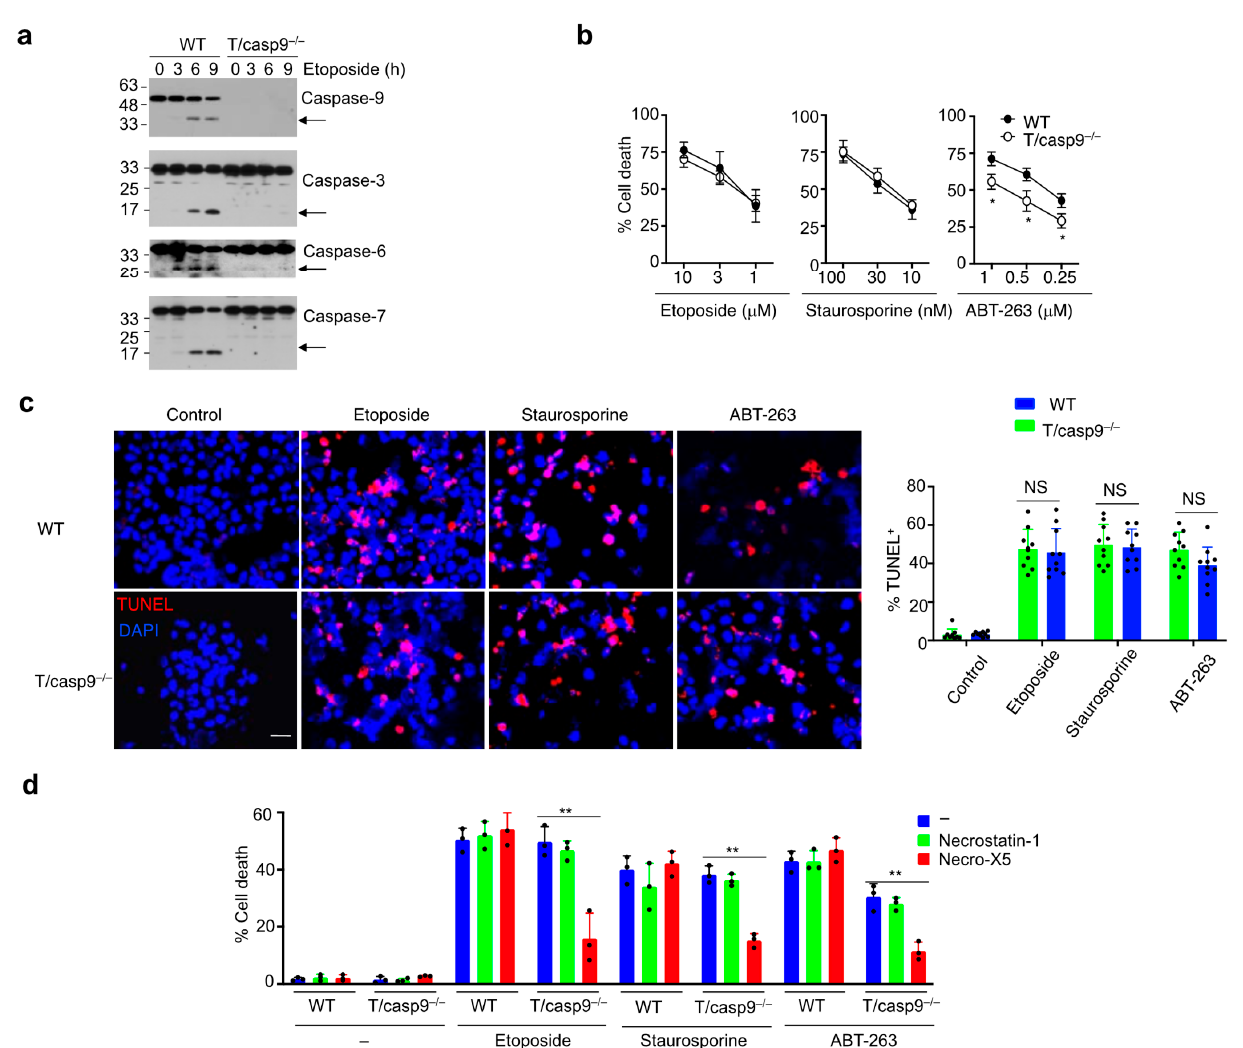
Figure 1. Cell death in caspase-9-deficient T cells. ( a ) T cells from wild-type (WT) or T/caspase-9 − / − (T/casp9 − / − ) mice were treated with etoposide and used for Western blot. Arrows indicate processed caspases. ( b ) Cell death in WT and caspase-9 − / − T cells triggered by different apoptosis stimuli for 24 h. Data are presented as mean ± SD. Comparison to control: * p < 0.05. ( c ) WT or caspase-9 − / − T cells treated with 1 μ M etoposide, 30 nM staurosporine or 1 μ M ABT-263 for 24 h were used for TUNEL staining (red) and nuclear counterstaining with DAPI (blue). Scale bar: 10 μ m. Comparison to control: NS: Statistically not significant. ( d ) Cells were treated with cell death stimuli as in ( c ) with or without 10 μ M necrostatin-1 or necroX-5. Percentages of cell death are presented as mean ± SD. Comparison to control: ** p < 0.01.